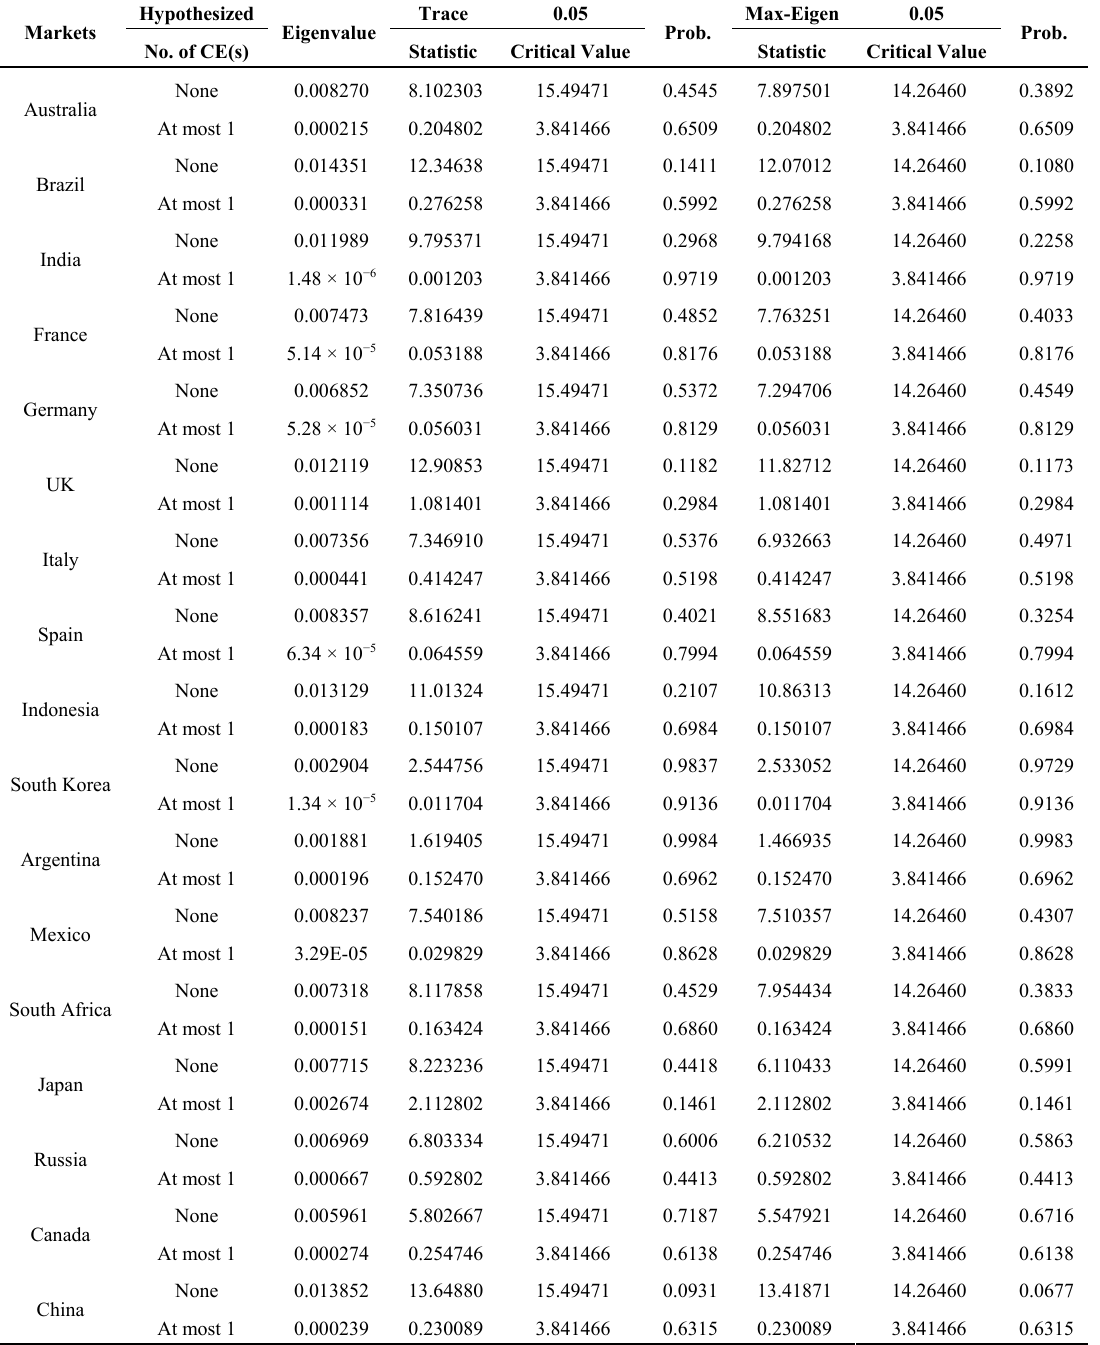
Table A7. Test for Johansen Cointegrtion in Main Period